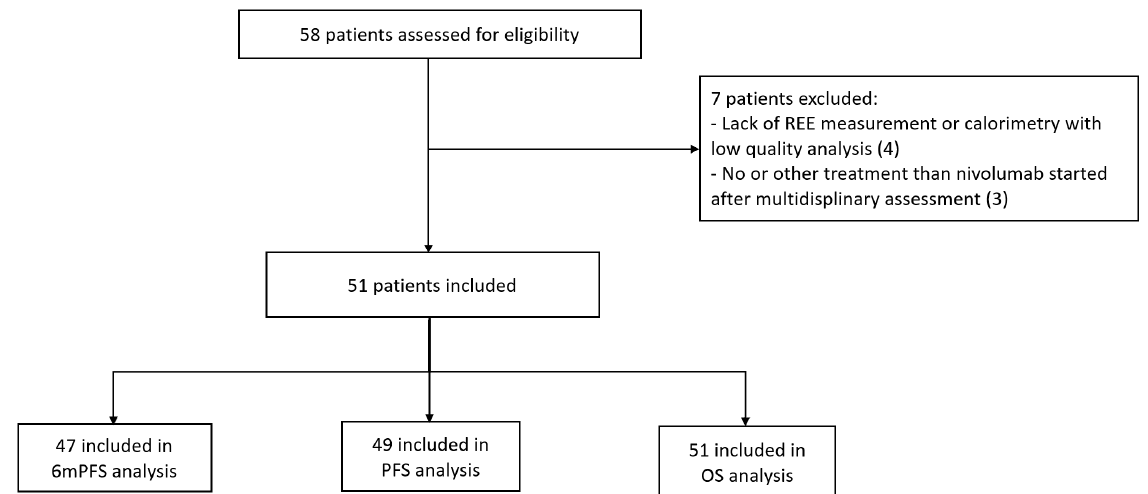
Figure 1. Flow chart. REE: resting energy expenditure; PFS: progression-free survival; 6 m PFS: 6-month progression-free survival; OS: overall survival.